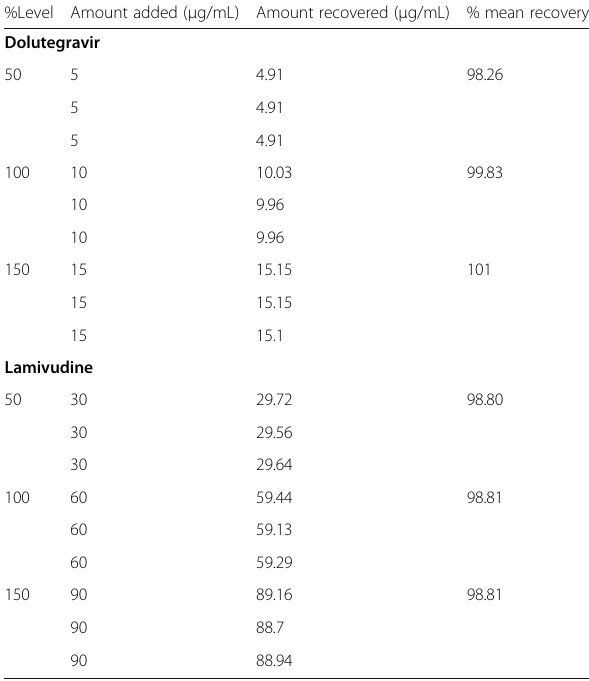
Table 4 Results of percentage recovery